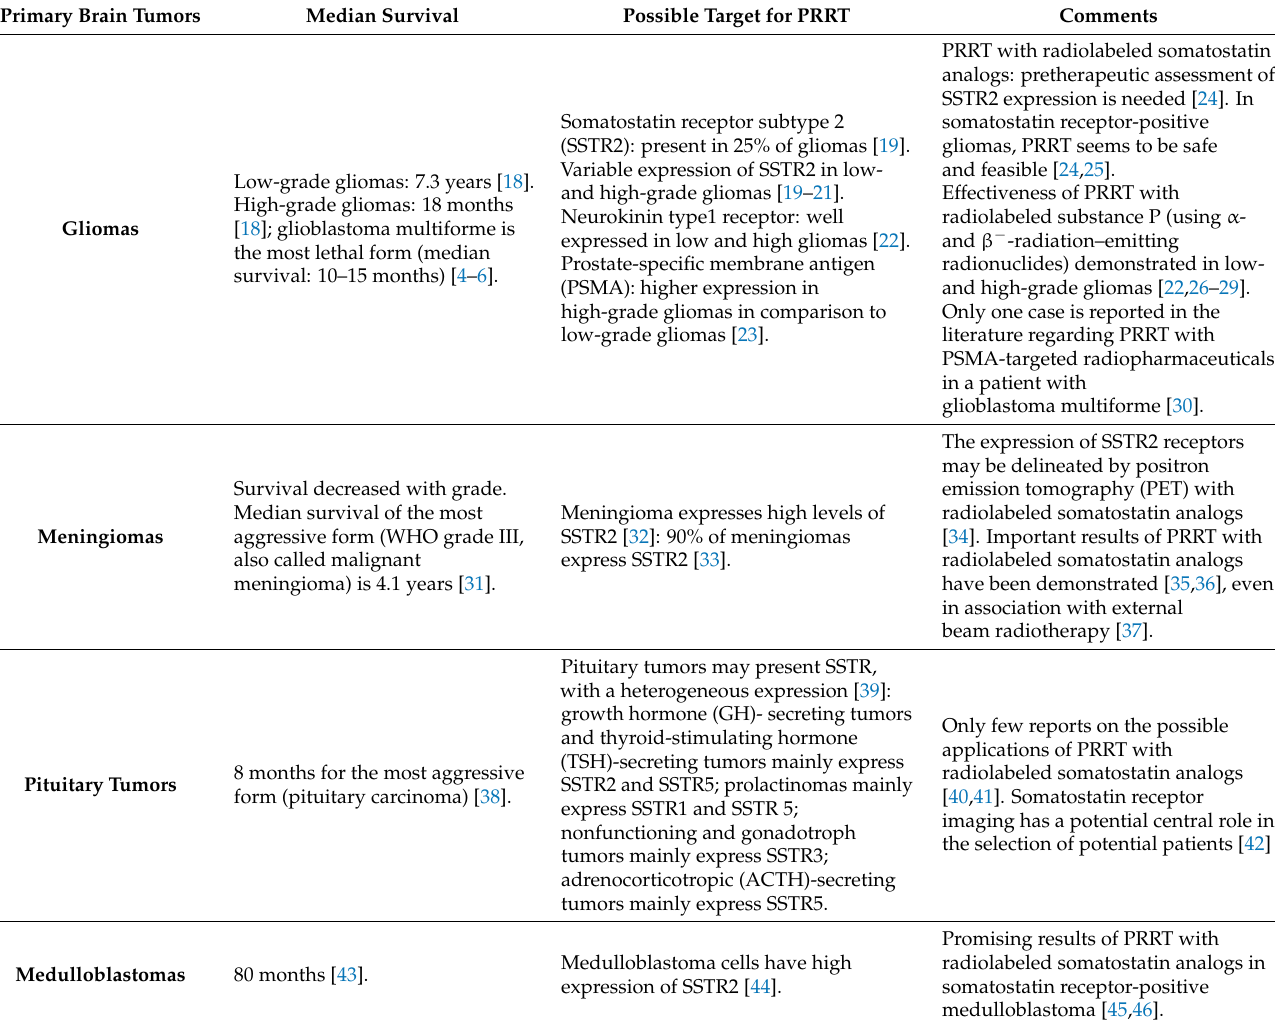
Table 1. Primary brain tumors and peptide receptor radionuclide therapy (PRRT): possible applications.